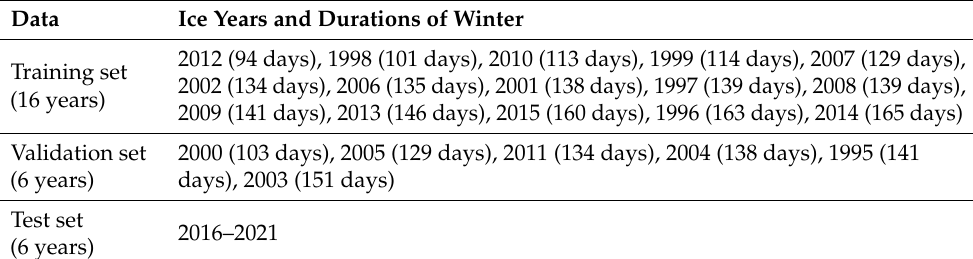
Table 2. Ice years in each of the training, validation, and test sets plus the duration of the winter. Data Ice Years and Durations of Winter Training